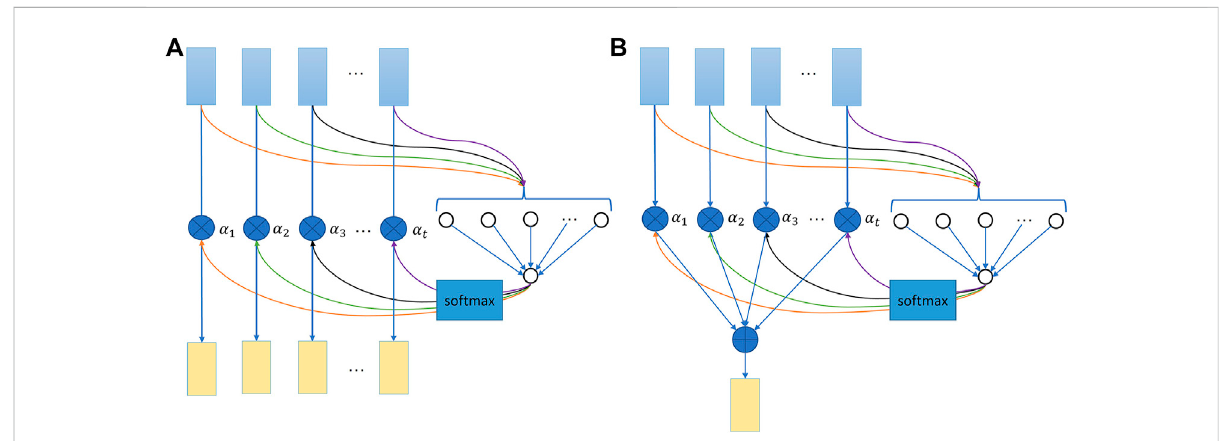
FIGURE 5 Attention mechanism illustration. (A) First attention layer. (B) Second attention layer. The attention score calculation for each timestep is independent but using the same learnable